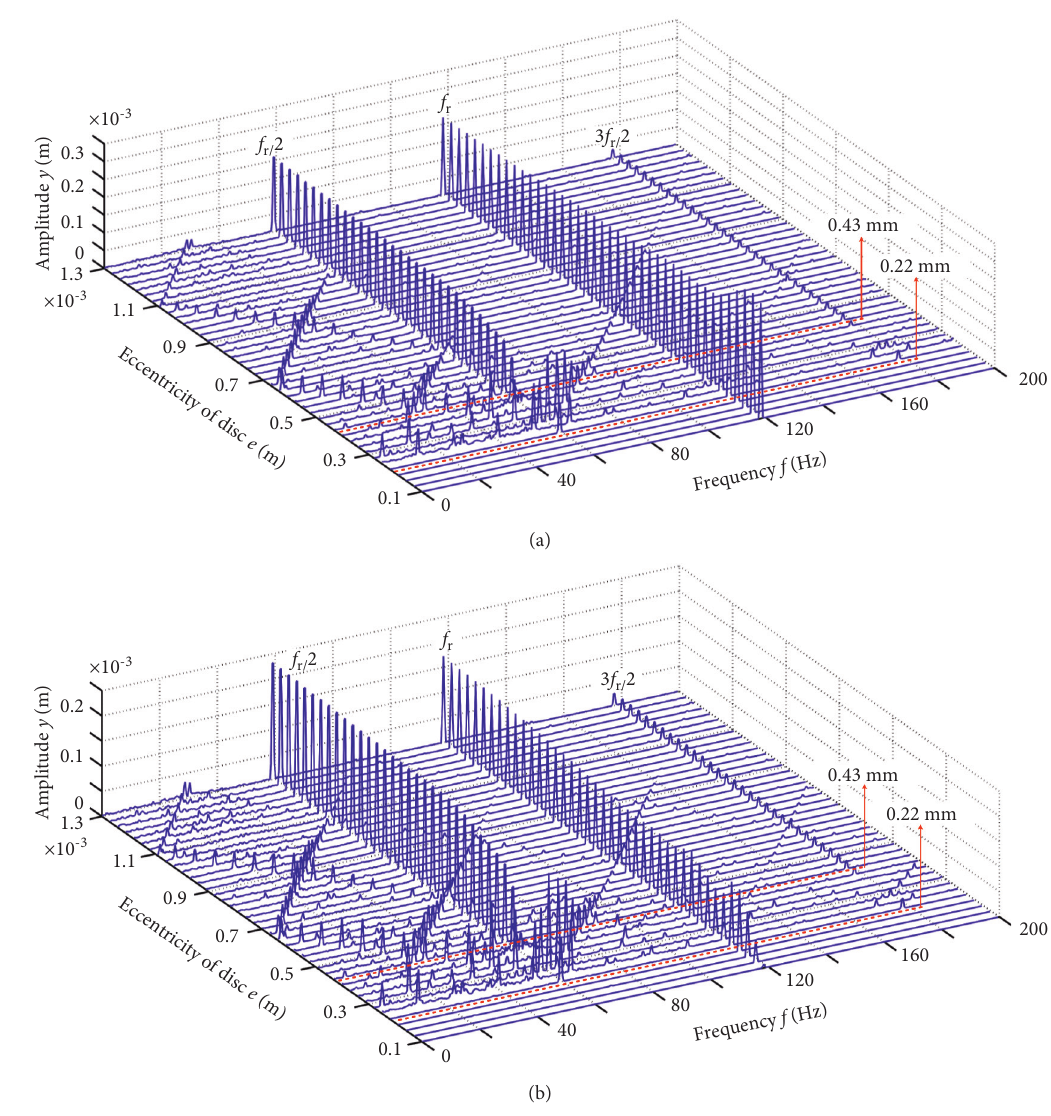
Figure 10: Spectrum cascades of the system with the change of the unbalance of two discs. (a) Spectrum cascade of right journal. (b) Spectrum cascade of right bearing